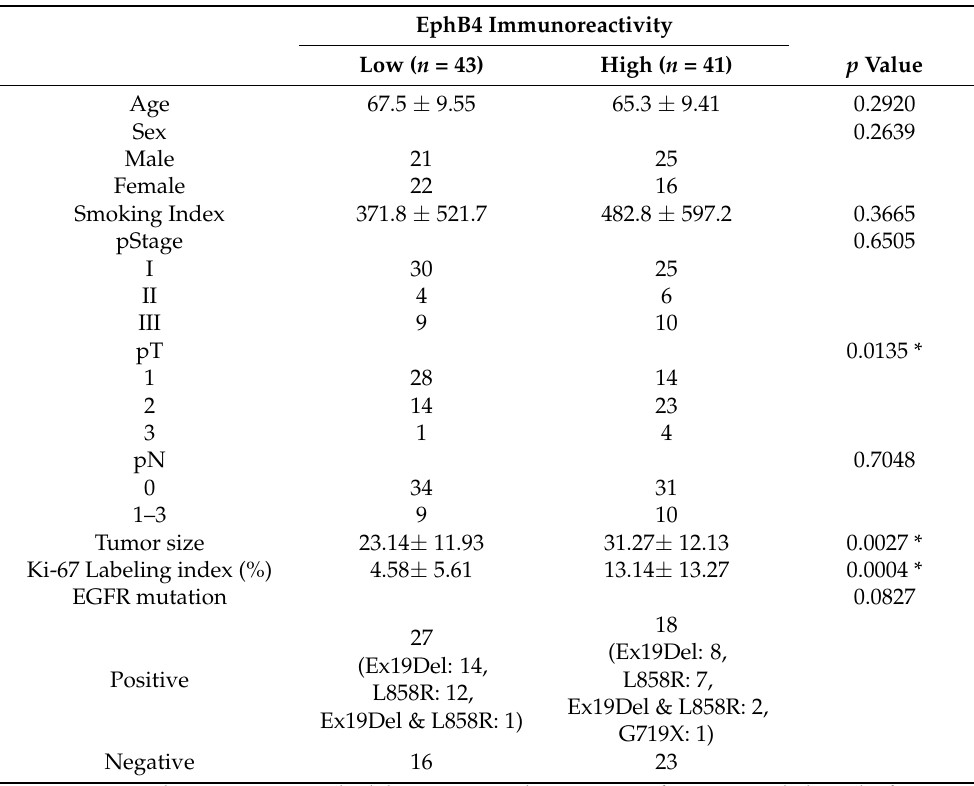
Table 1. The association between EphB4 immunoreactivity and clinicopathological factors in patients with lung adenocarcinoma ( n =